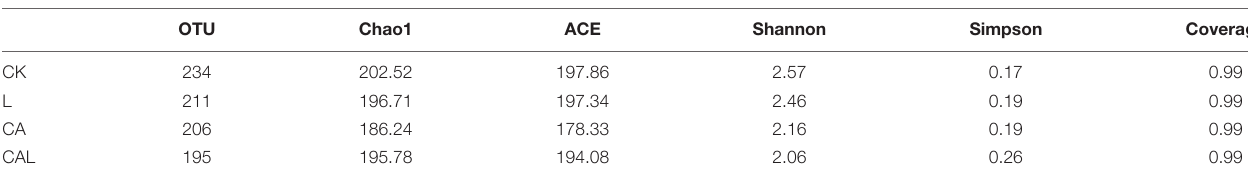
TABLE 4 | Alpha-diversity of bacterial diversity of KG